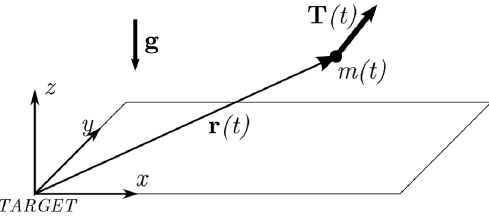
Figure 4. Ground Reference System